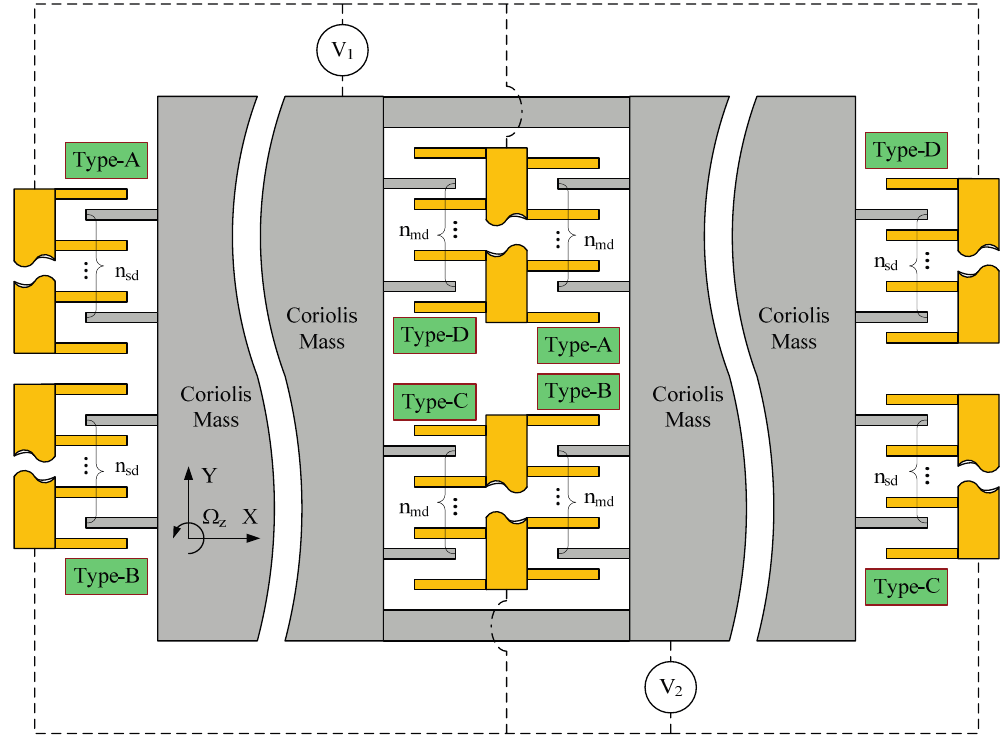
Figure 3. A novel layout design of quadrature compensation patterns.